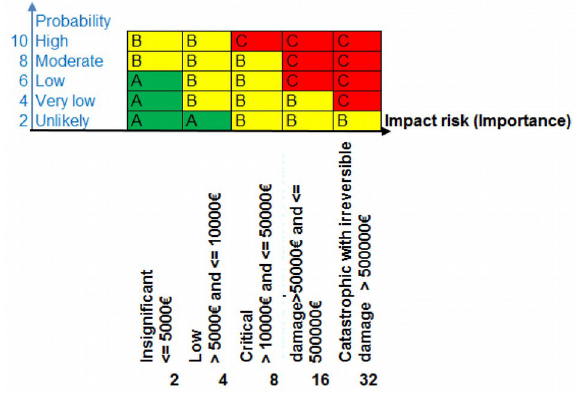
Figure 3. Risk criteria definition: Case